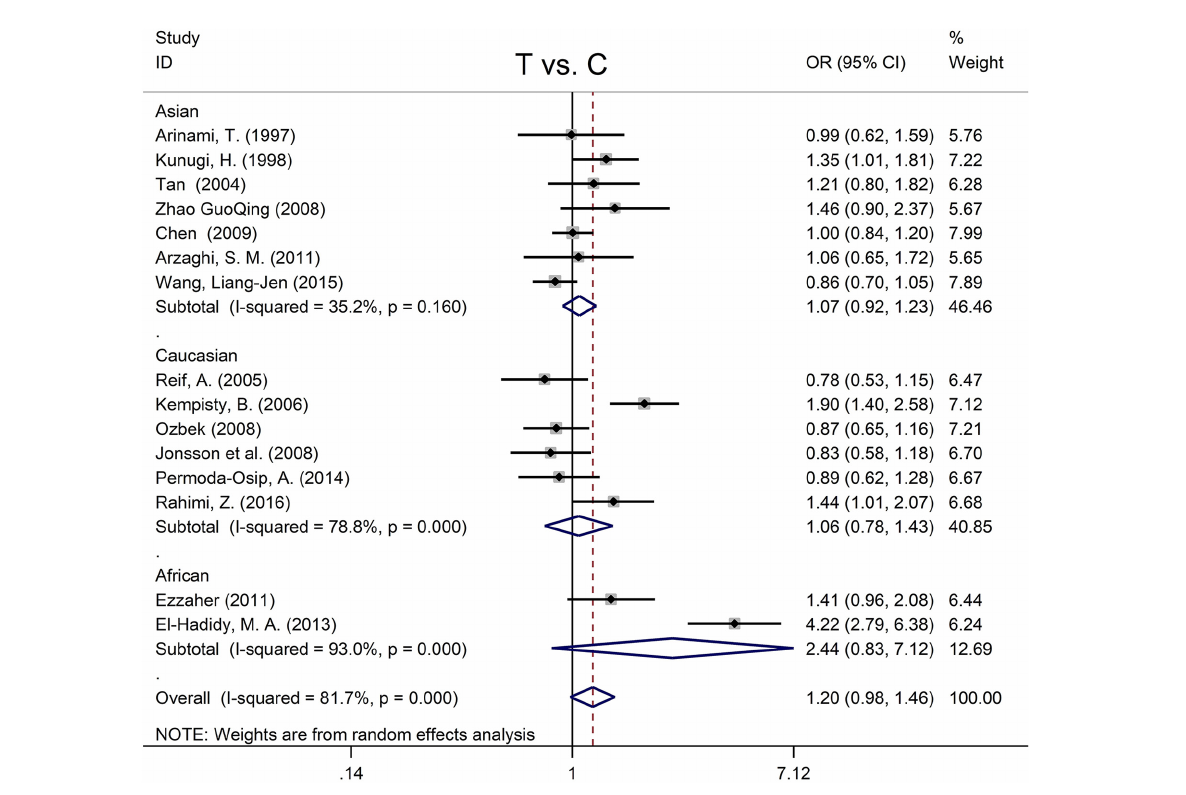
FIGURE6 Forest plots for the associations between MTHFR C677T polymorphisms and BPD for the allele model with random effect model.